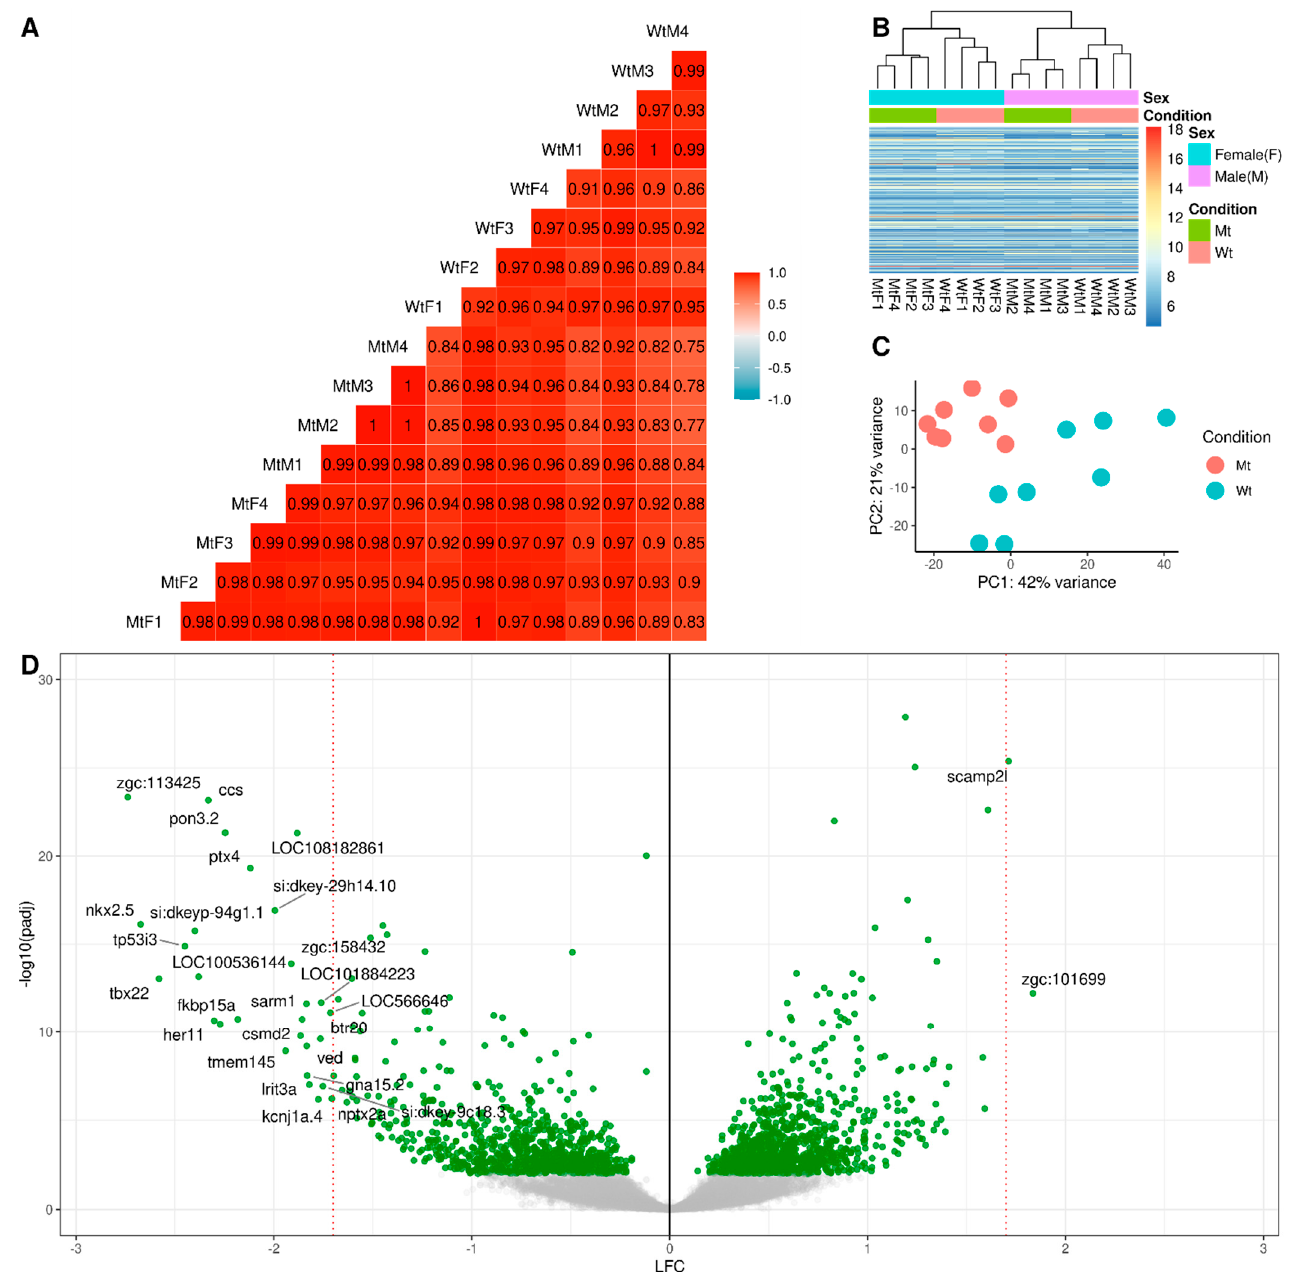
Figure 1. Quality Control and Fold Change. Total samples ( n = 16), with sex-matched groups: MtM: Mutant Male ( n = 4), MtF: Mutant Female ( n = 4), WtM: Wild type Male ( n = 4), WtF: Wild type Female ( n = 4). ( A ) Pearson Correlation for pairwise comparison of mRNA FPKM between samples, rounded to 2 decimals; ( B ) Heatmap clustering of variance stabilized counts for all genes binned into five hundred clusters, showing that both sex and condition are clustering together; ( C ) PCA analysis of variance stabilized counts for all genes, with batch correction for both Sex and Replicates; ( D ) Volcano plot of Log2 fold change (LFC) for all genes using DESeq2 differential expression analysis, with resulting − log10 adjusted p -values. (Negative LFC means LFC (Mutant Mt) < LFC (Wild type Wt). A high confidence set of genes are displayed with gene symbols (adjusted p -value < 0.000001 and absolute value of LFC > 1.7).